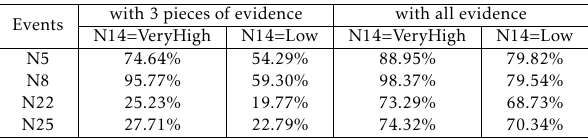
Table 6. Results of Experiment